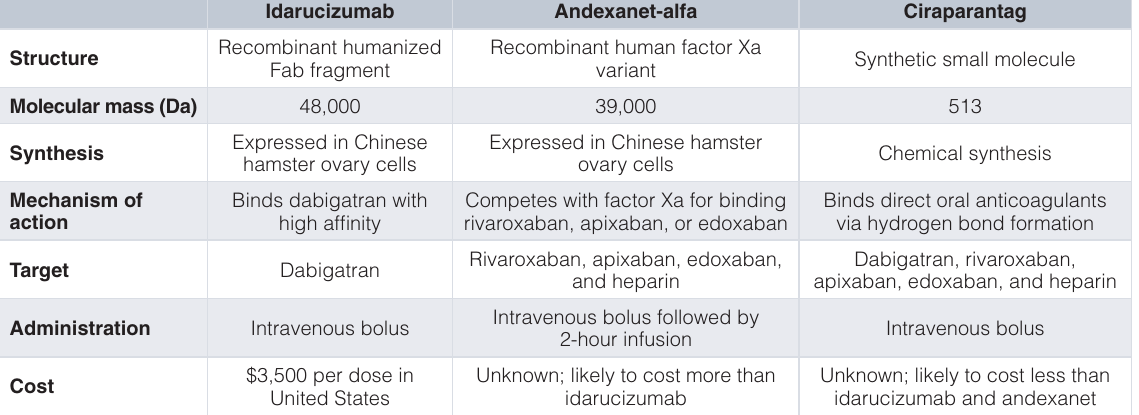
Table 6. Features of specific reversal agents for the direct oral anticoagulants.